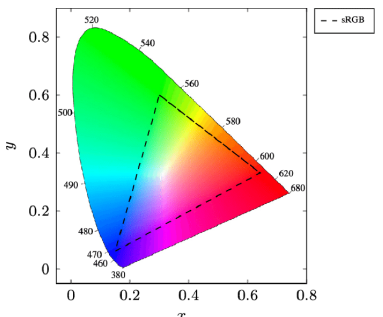
Figure 2. The xyY diagram of the Commission Internationale de